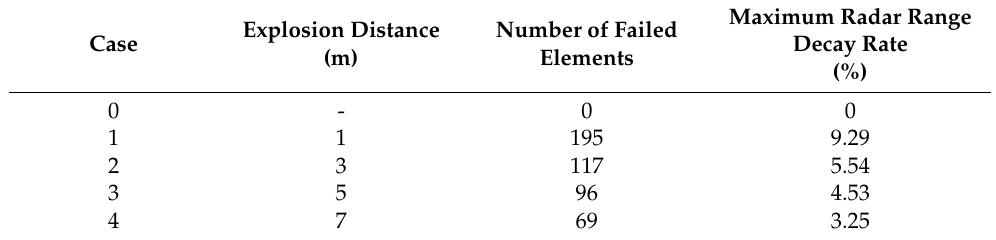
Figure 7. Failure diagrams of the phased-array antenna at di ff erent explosion distances: ( a ) 1 m, ( b ) 3 m, ( c ) 5 m, ( d ) 7 m. Table 5. Transmi tt ing parameters at di ff erent explosion distances in the transmi tt ing mode. Table 5. Transmitting parameters at different explosion distances in the transmitting mode.